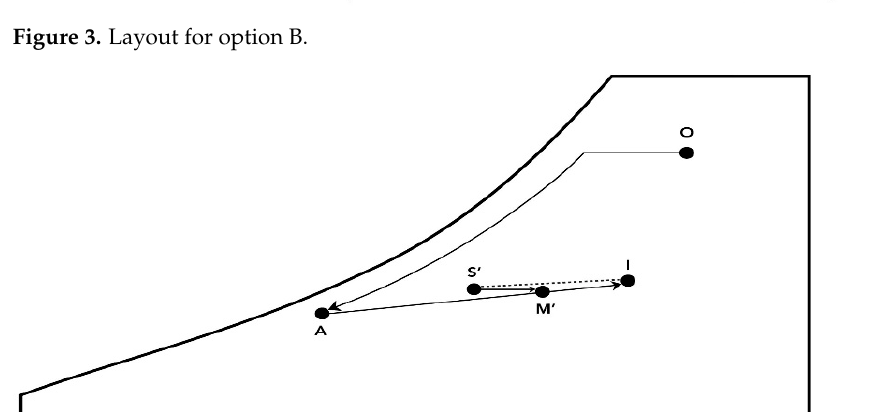
Figure 3. Layout for option B.